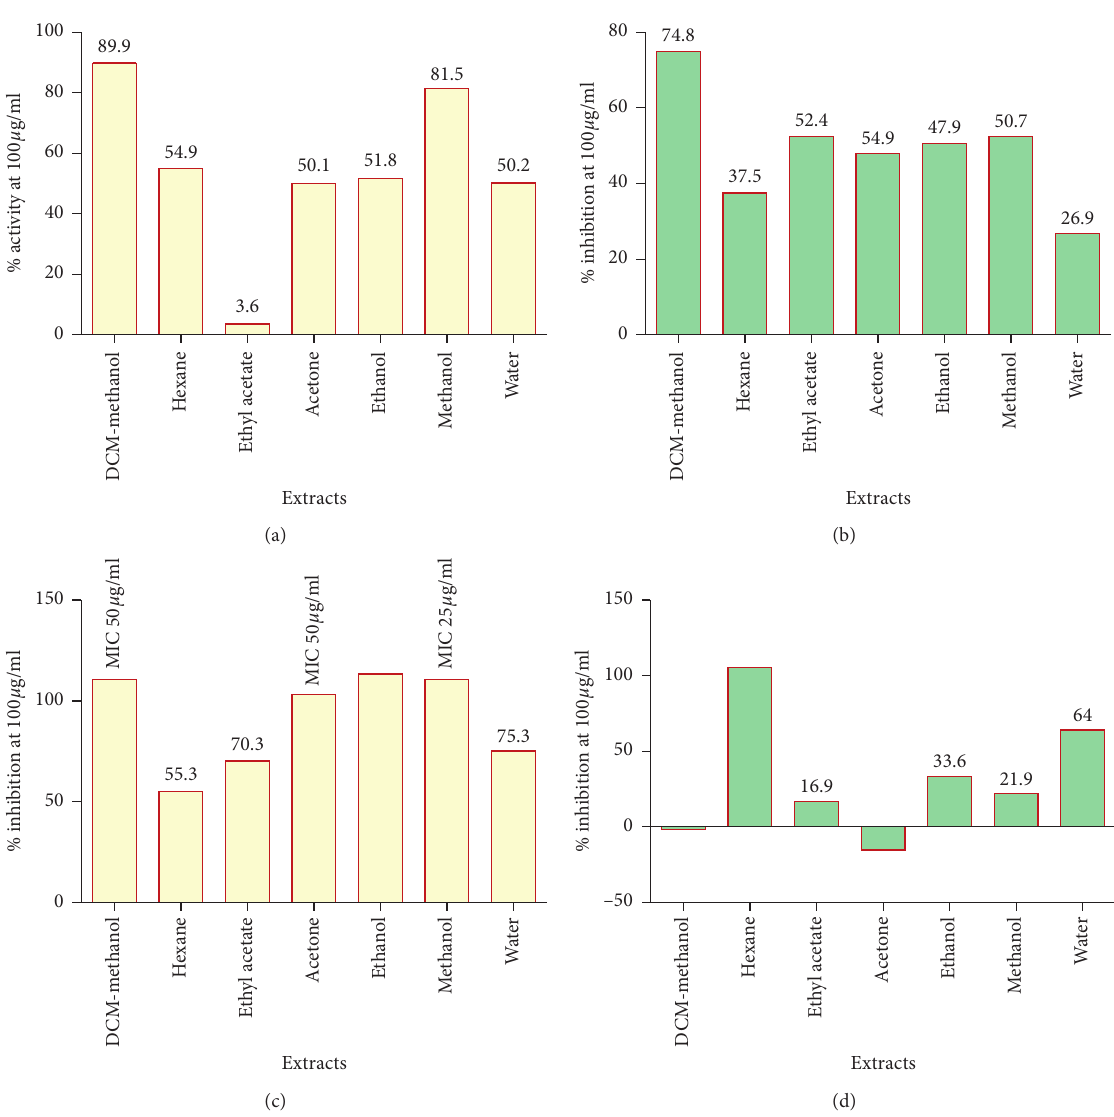
Figure 3: Percentage inhibition of the crude P. curatellifolia extracts at 100 µ g/mL on the growth of S. aureus (a), K. pneumoniae (b), M. smegmatis (c), and C. krusei cells